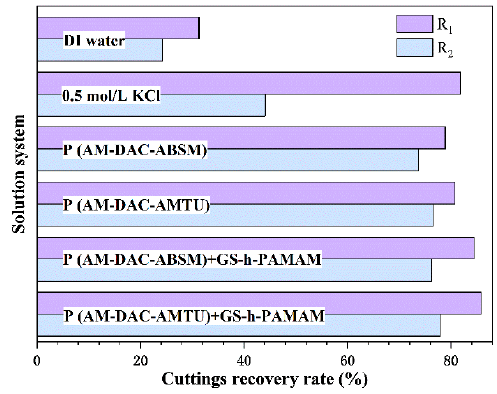
Figure 9. Cuttings recovery rate of di ff erent